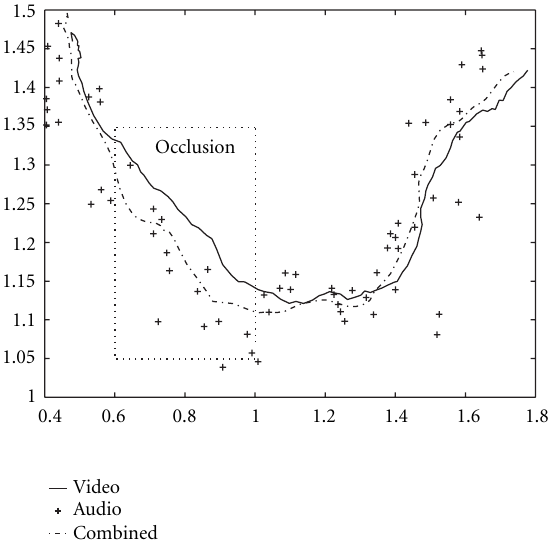
Figure 6: An object track recovered with and without self- calibration. Figure 7: Track of the ( X,Y )-coordinates of a person through a simulated